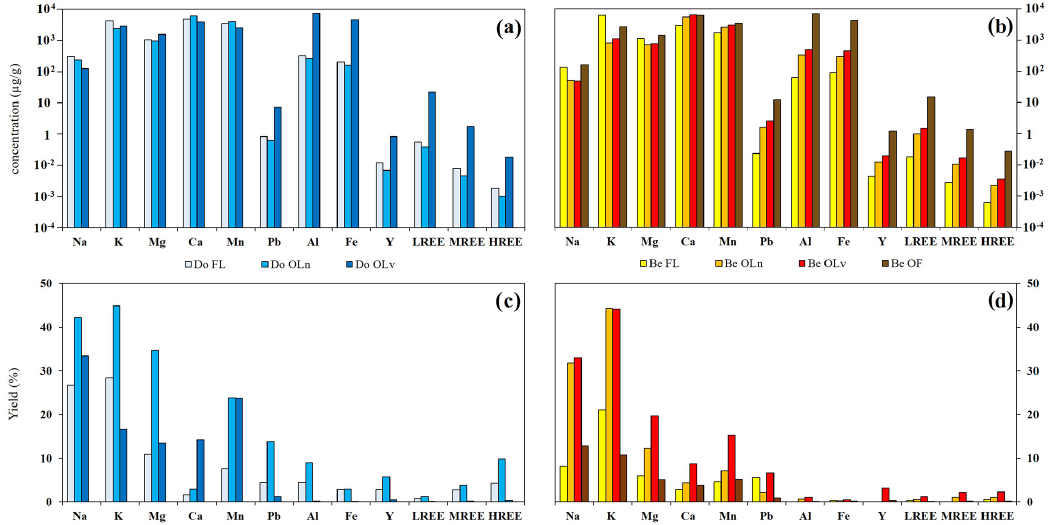
Figure 2. Log 10 of the concentrations of the study elements in fresh leaves and different litter fractions of (a) Douglas-fir and (b) European beech; element yields (% of the total mass) for the leaching experiment of (c) Douglas-fir and (d) European beech fresh leaves and litter